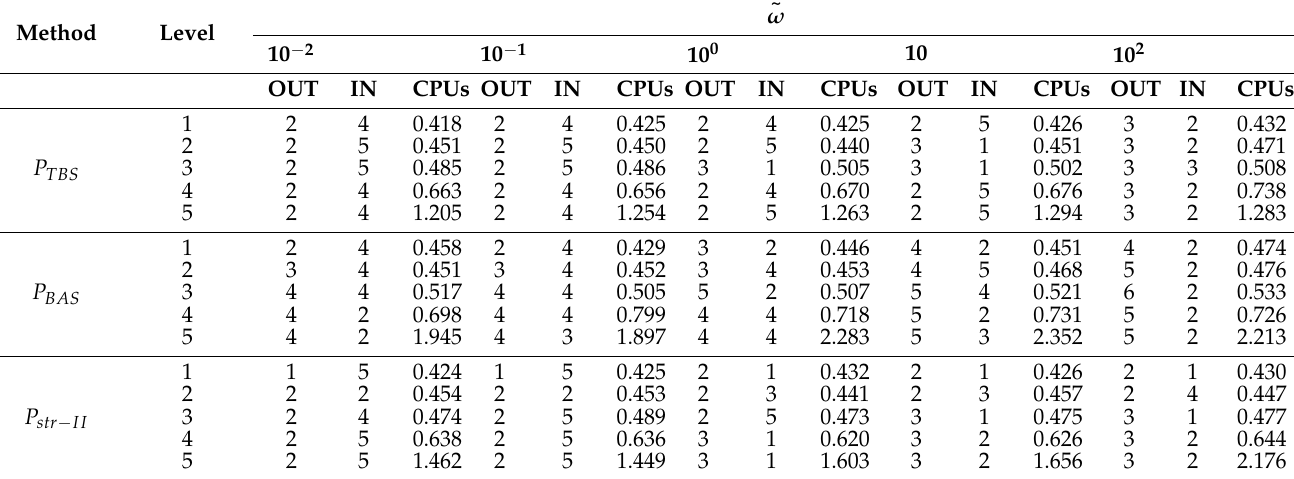
Table 4. Different mesh refinement levels and (cid:101) ω , the result of the preconditioned GMRES (5) in the 2D case, with ε = 10 − 2 . Method